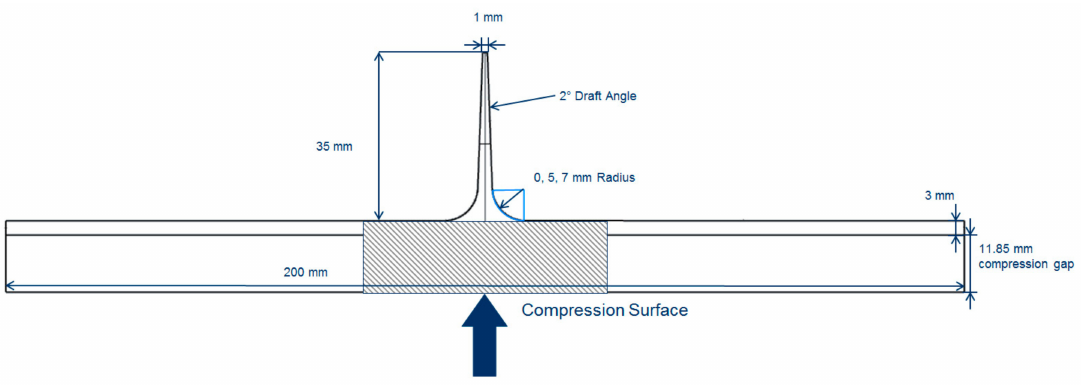
Figure 6. Cross section of rib. Width (into page) was adjusted based on fiber length. The striped sections show charge